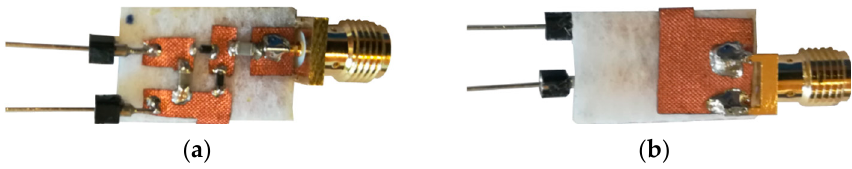
Figure 6. Textile rectifier: ( a ) Top layer; ( b ) Bottom layer.